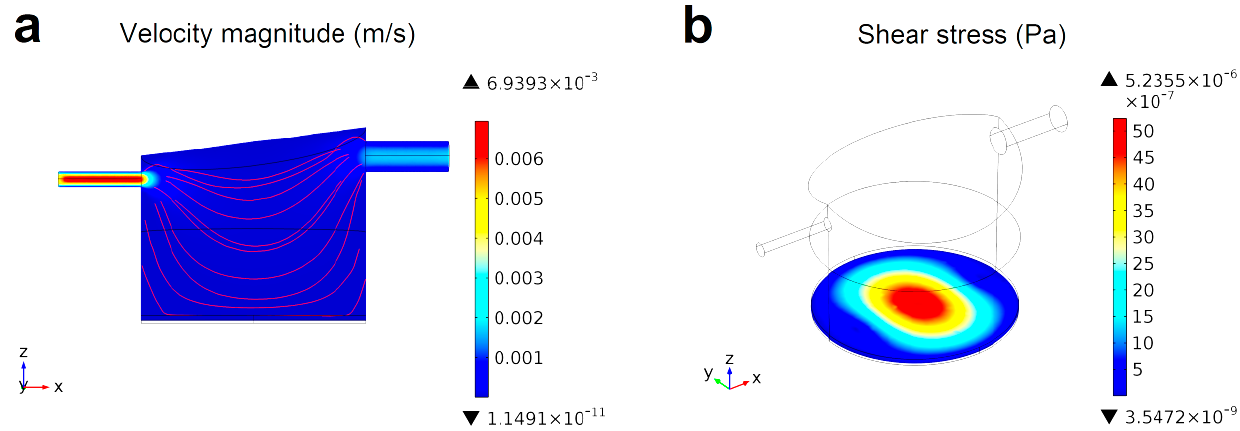
Figure 8. Fluid dynamics in the MCmB culture chamber at 180 μL /min inflow considering a 0.2 mm thick hydrogel construct located at its bottom: ( a ) Velocity field at the central vertical section of the culture chamber passing through the middle of the inlet and outlet tubes. Flow streamlines (in red) are parallel to the hydrogel surface; ( b ) Flow-induced shear stress on the hydrogel surface.